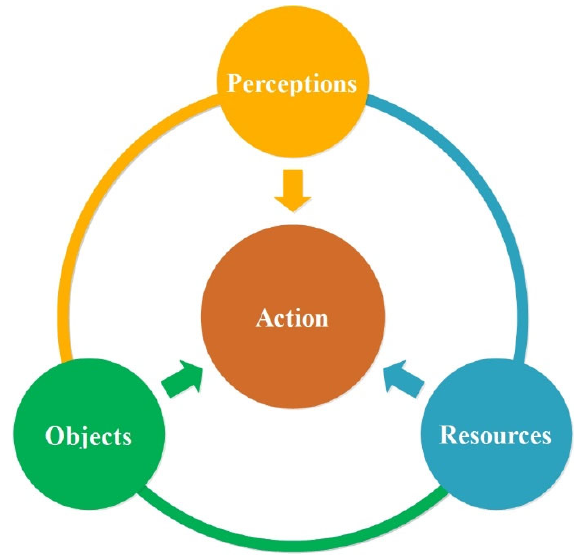
Figure 1. The effective parameters of the actors’ actions.